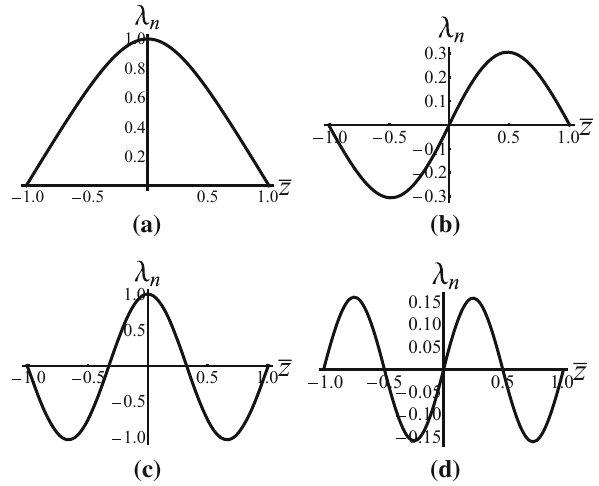
Fig. 5 The wave functions of the lower scalar KK modes. The param- eters are set to k = − 2 , ¯ θ = 4 . 77 , ¯ z b = 1, and ¯ u = 1 . 43 ¯ z = ±¯ z δ functions, and the effective b having two positive ¯ V s ( ¯ z ) just like an infinite high barrier. Therefore, the potential solutions at the high excited states should be trigonometric functions with the same mass gap. By increasing the value of < 0 will the parameter ¯ u , the bound state solution with ¯ m 2 n appear. Therefore, in order to obtain nonnegative eigenvalues ¯ m 2 , the mass parameter ¯ u will have an upper limit when the ¯ θ = other parameters are fixed. For k = − 2 , 4 . 77 , ¯ z b = 1, as we have chosen here, the upper limit of ¯ u is 1 .